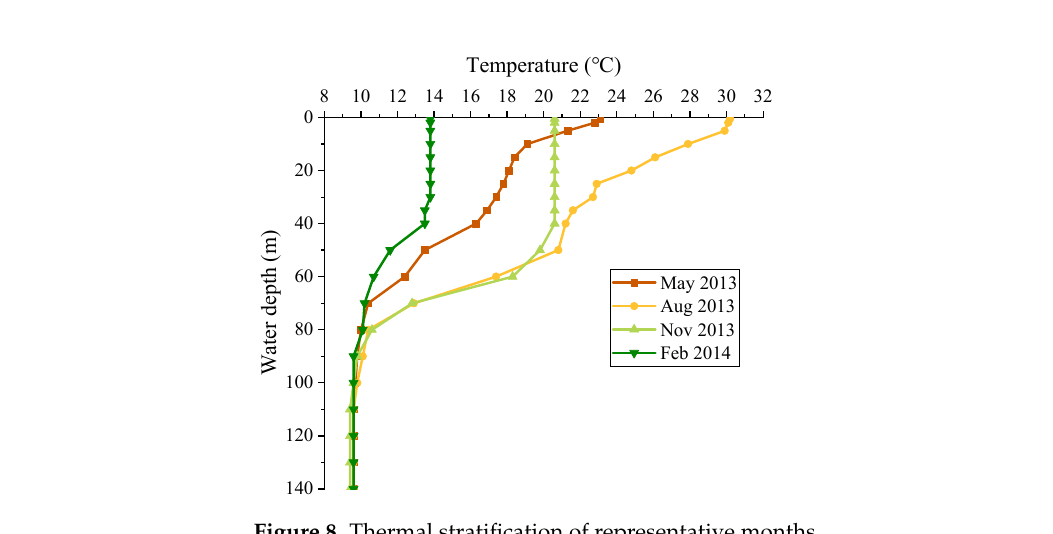
Figure 8. Thermal stratification of representative months.